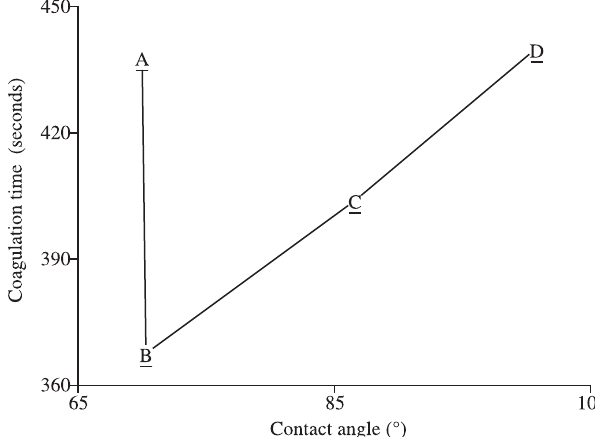
Figure 6. Coagulation time of blood in contact with surfaces with different contact angles. A_ indicates the value obtained from glass surfaces coated by PECVD of heparin/isopropanol solution. In B_ pristine PVC specimens have been immersed in blood. Condition C_ refers to glass slides coated by PECVD from heparin/HMDSO solution and the result in D was obtained with PVC specimens exposed to SF 6